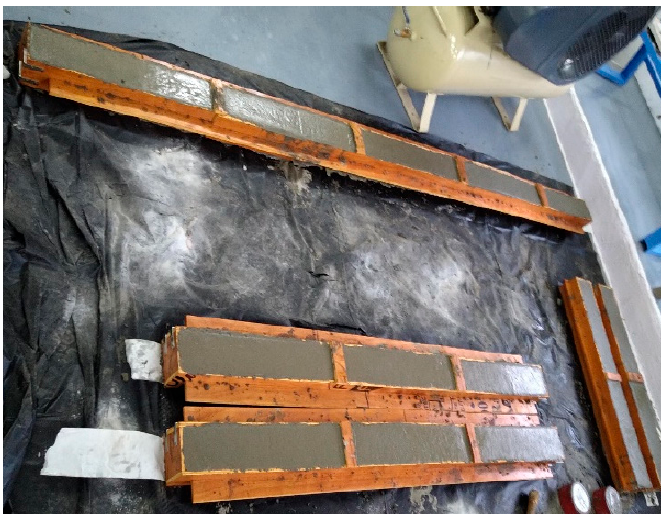
Figure 11. Casting of beams and columns.